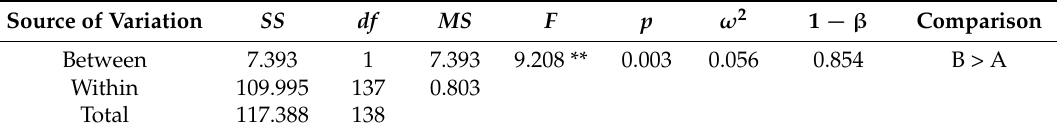
Table 4. ANOVA for job tenure difference in perceived hazard management: Physical hazards. Source of